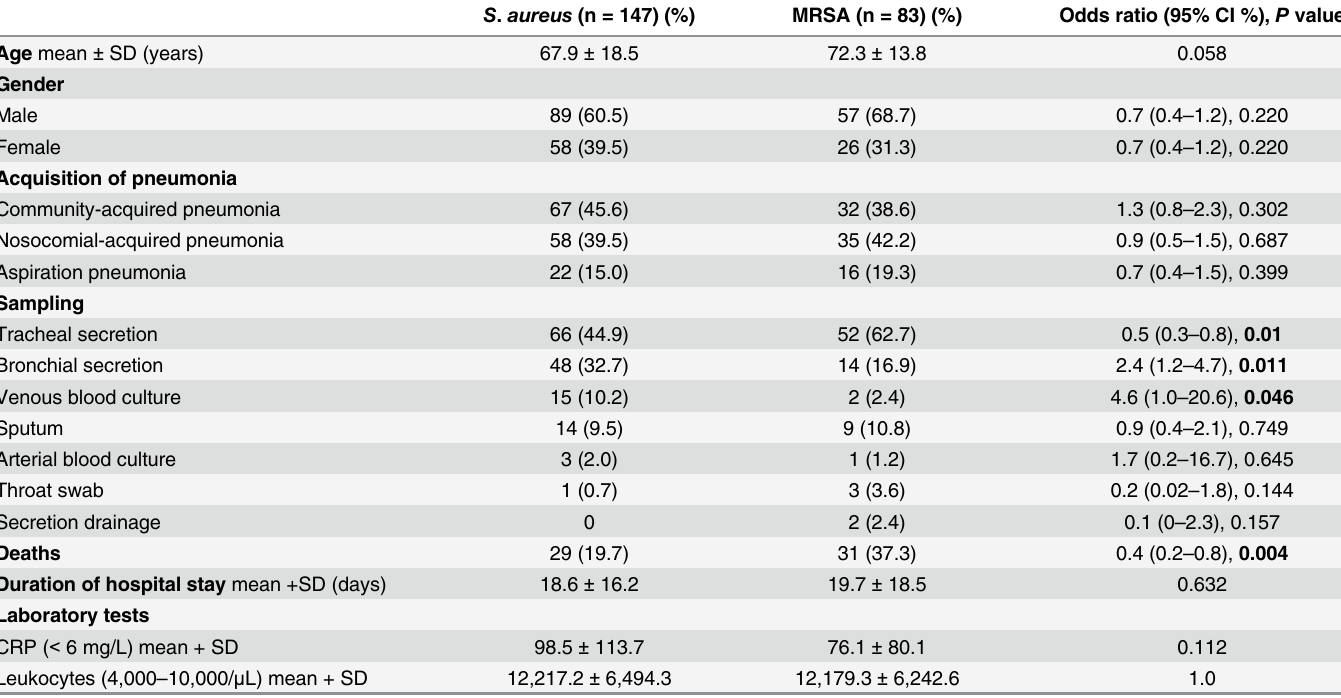
Table 2. Comparison of gender, acquisition, and sampling in patients with pneumonia caused by S . aureus compared to